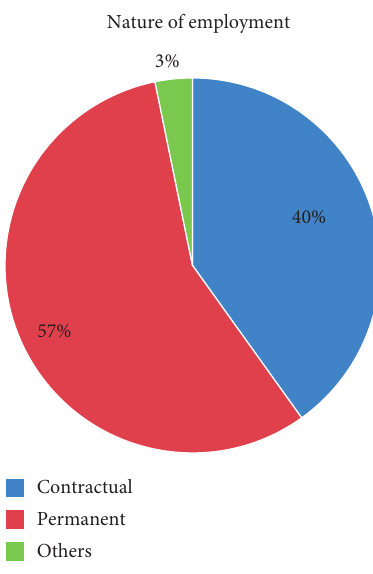
Figure 2: Nature of